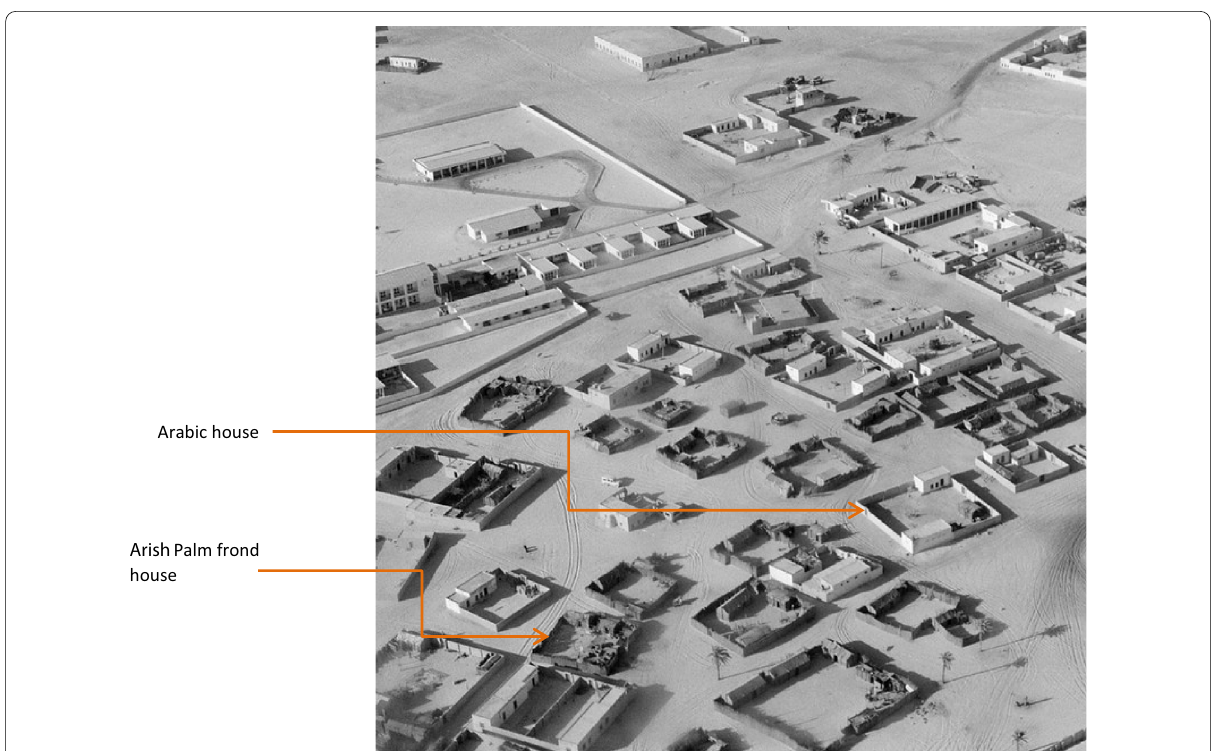
Fig. 2 Aerial view of the island of Abu Dhabi in the early 1960s. Photo shows palm-frond/Arish and Arabic houses. These house forms had add-on gradual features. Source: Used with permission from BP Archive, University of Warwick ©BP